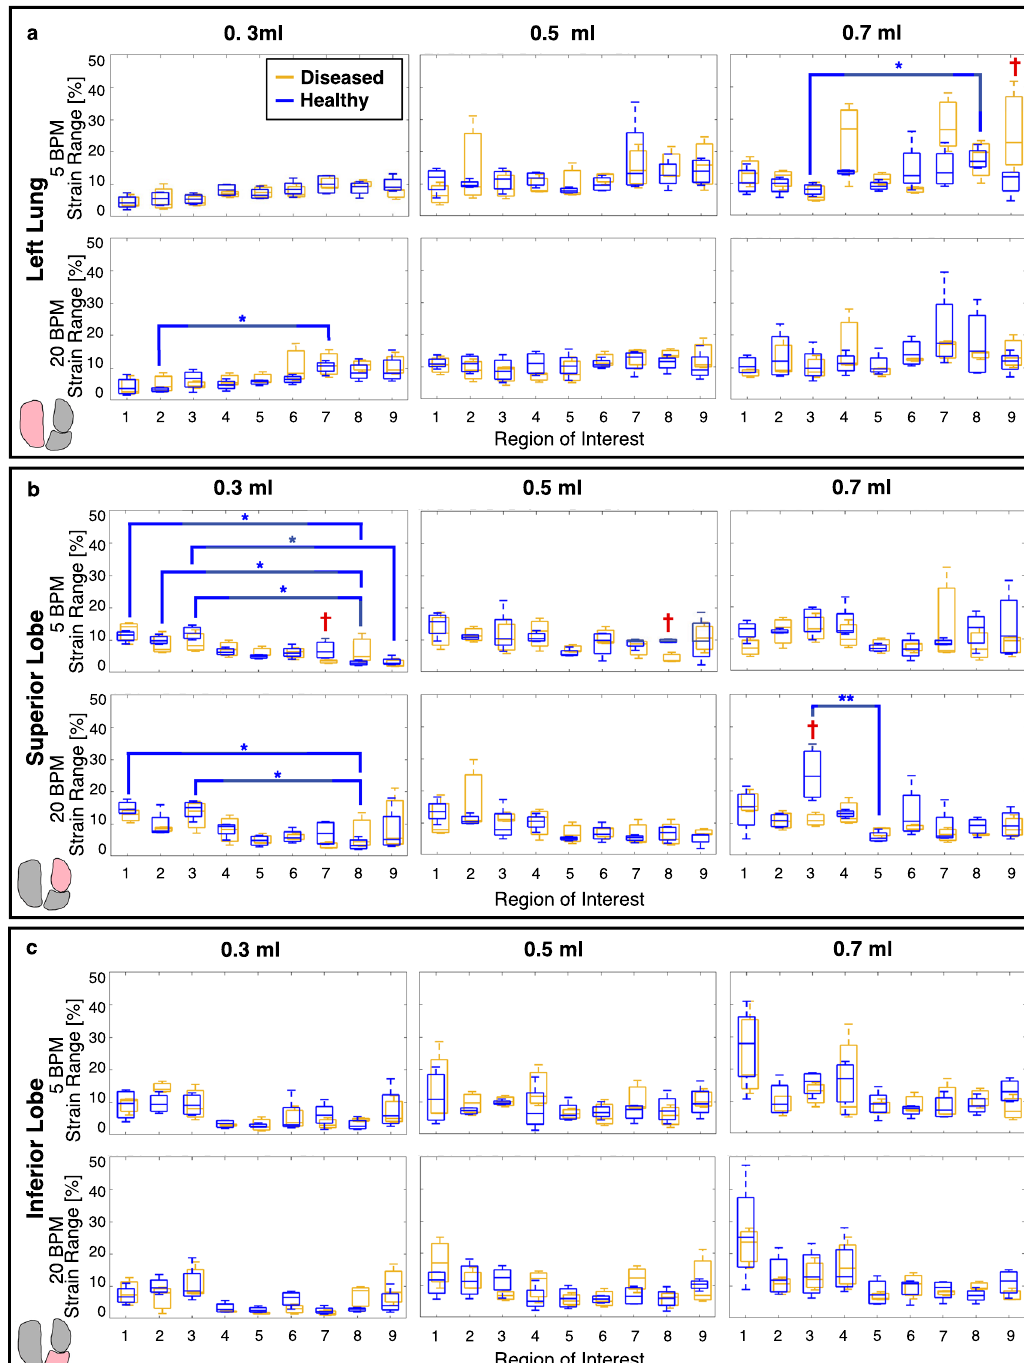
Figure 6. Box and whisker plot representation of diseased (gold) and healthy (blue) strain range within each ROI for the ( a ) left lung, ( b ) superior lobe and ( c ) inferior lobe, at each applied volume and breathing rate. Significant diseased versus healthy differences are indicated with red daggers, and significant differences between each of the regions within healthy lungs’ groups are denoted by blue asterisks. Intercomparisons of the diseased ROIs yielded no significant